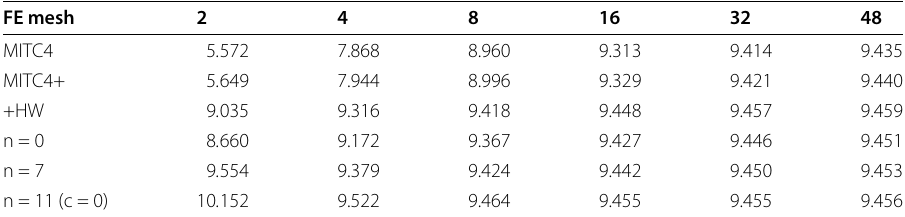
Table 2 Cook’s problem: convergence behavior u yA − N FE